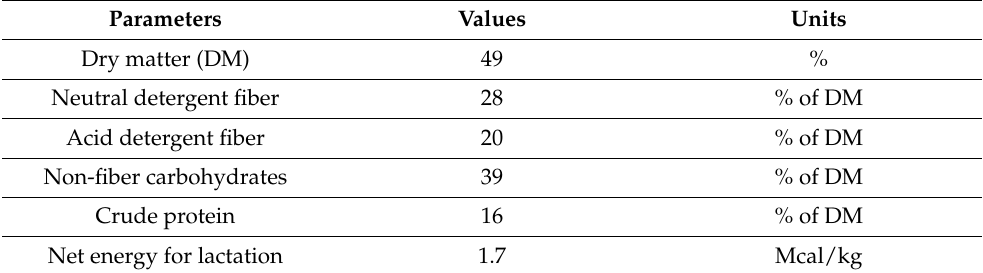
Table 2. Composition of ration.